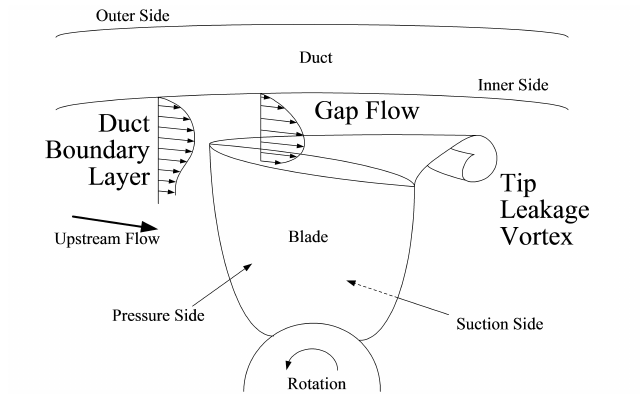
Figure 1. Schematic overview of the flow in the gap region between blade tip and duct inner